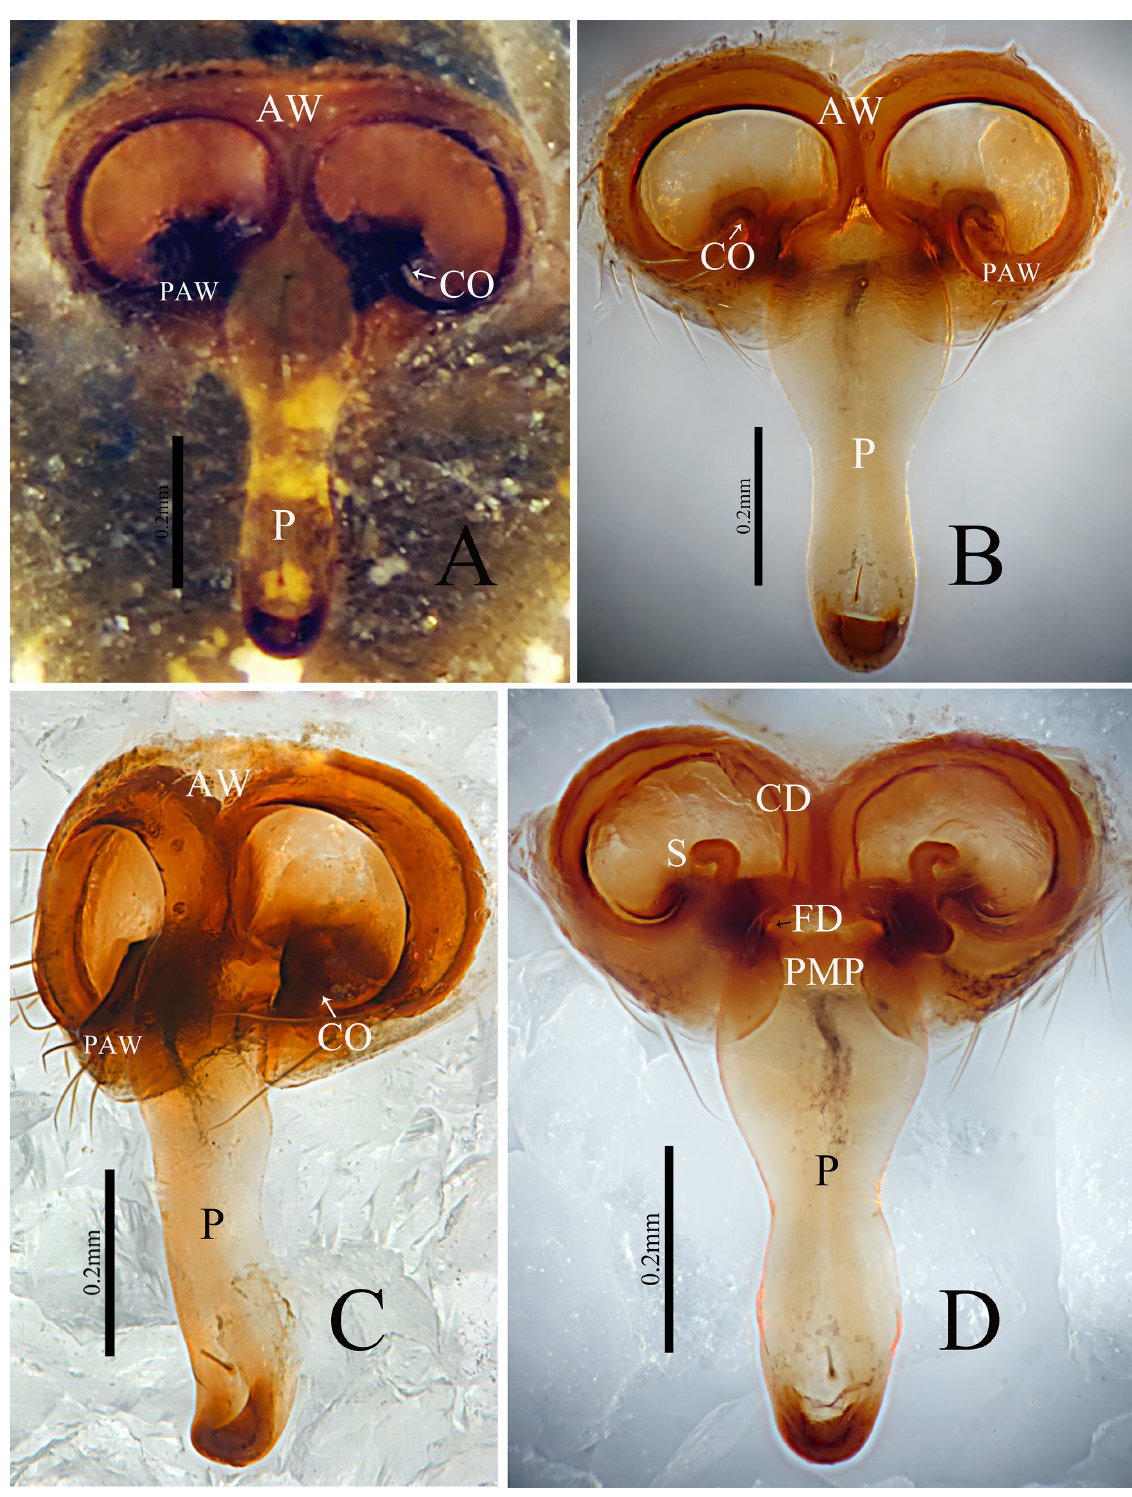
Fig. 36. Acroterius ovatus gen. et sp. nov., ♀, holotype (HNU-YHY06). A–B . Epigyne, ventral view. C . Epigyne, lateral view. D . Vulva, dorsal